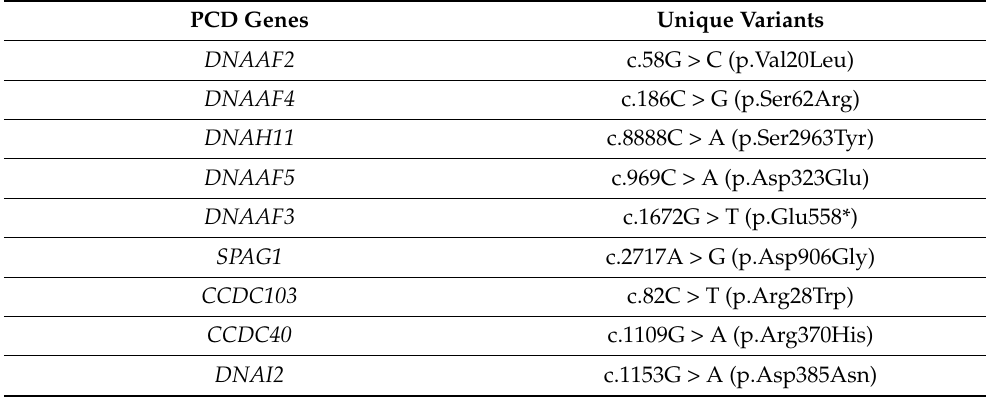
Table A2. Complete list of VUS